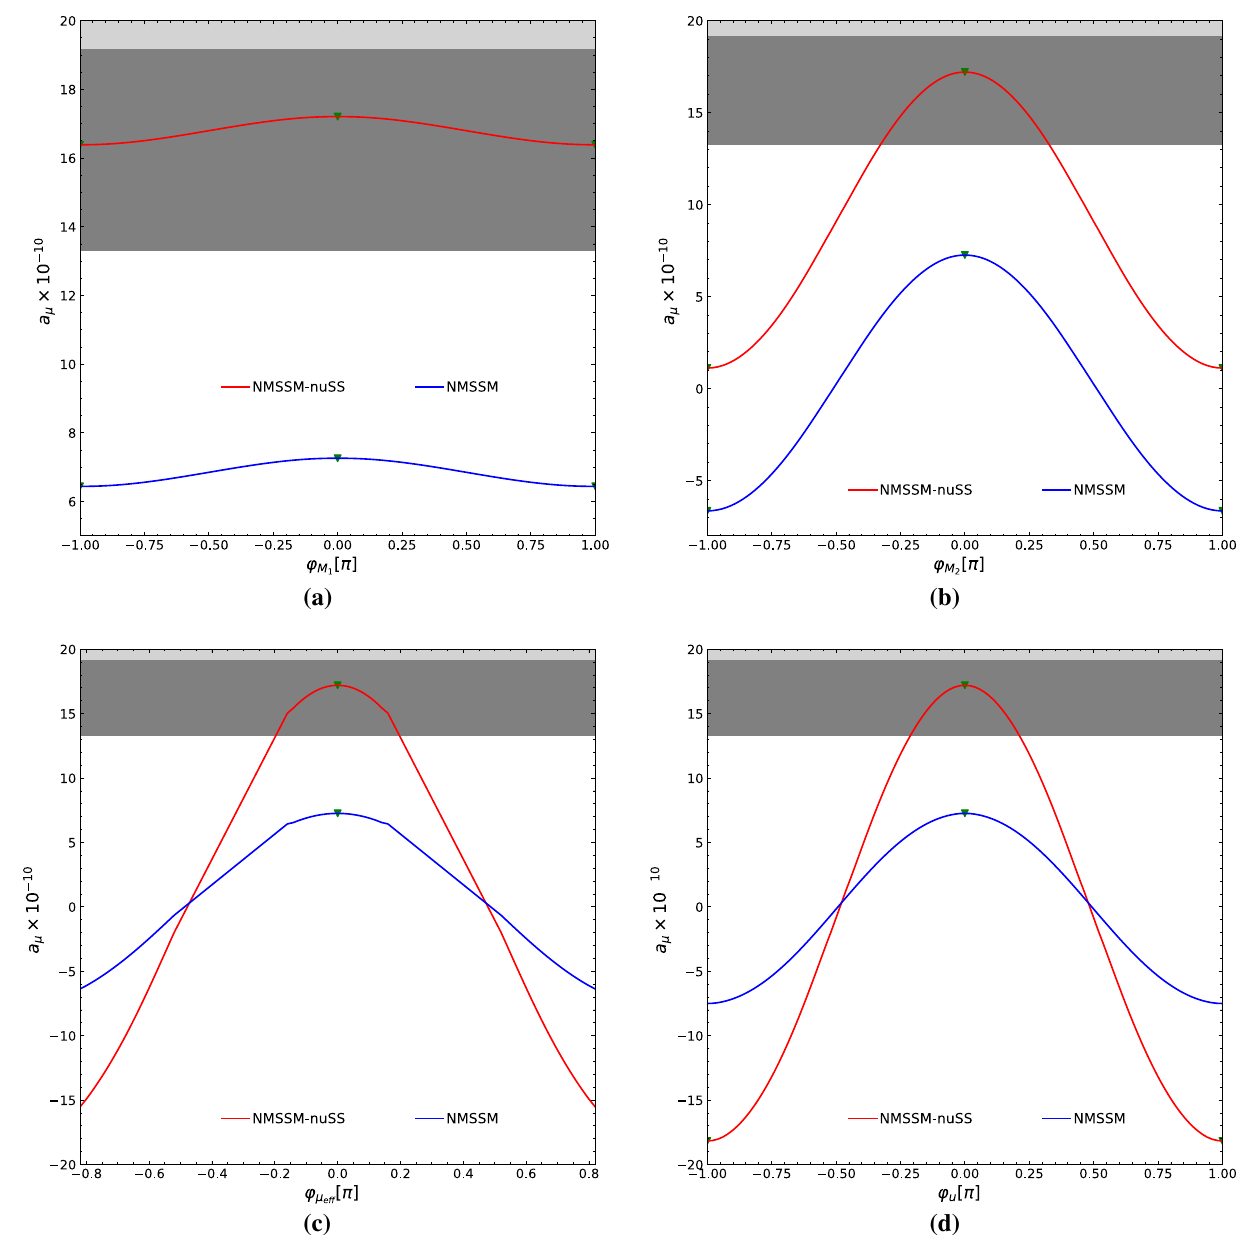
Fig. 6 The AMM of the muon in the NMSSM with (red) and without (blue) inverse seesaw mechanism as a function of several CP-violating phases: a ϕ M , b ϕ M , c ϕ μ , d ϕ 1 2 eff